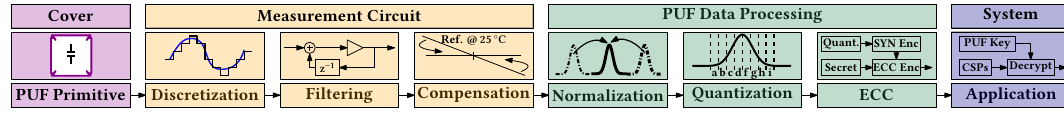
Figure 3: PUF data processing concept of the evaluation